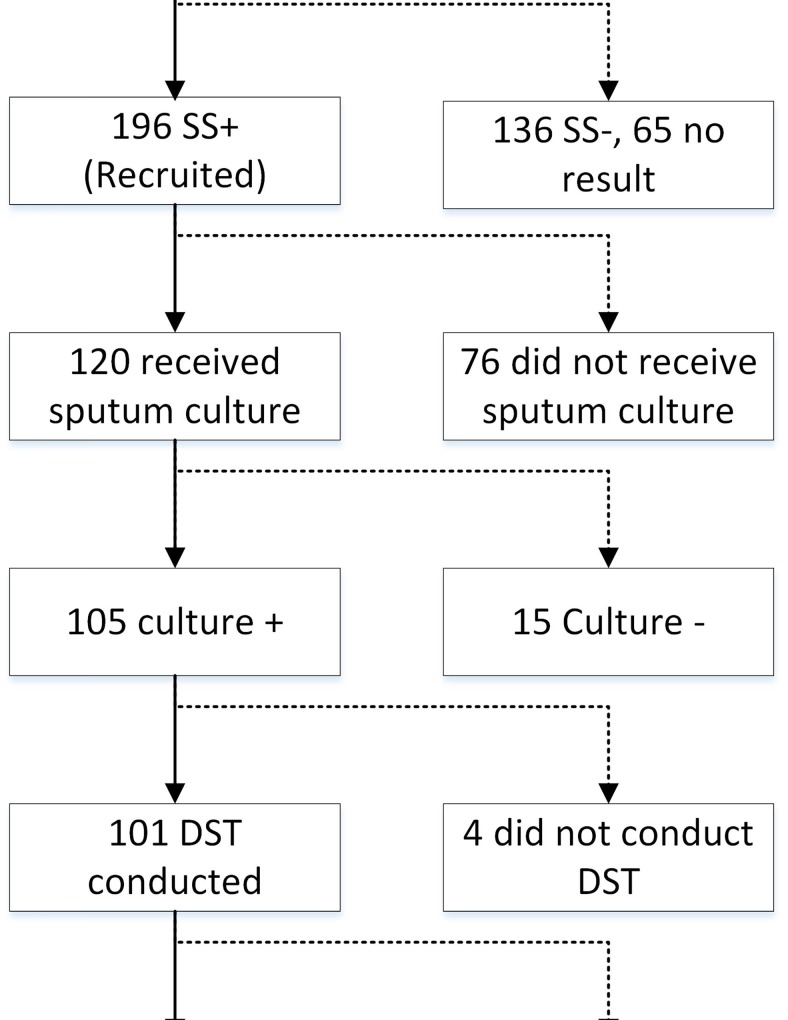
Disposition of TB retreatment patients who were initially screened (n = 397) and of recruited patients who had positive sputum smears (SS+, n = 196) from June 2012 to May 2013.